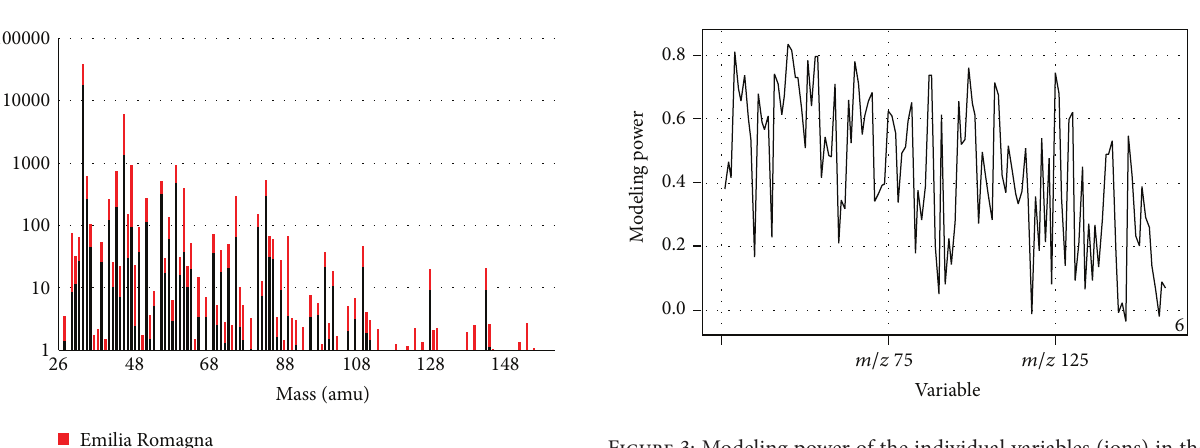
Figure 3: Modeling power of the individual variables (ions) in the Principal Component Analysis of the normalized and autoscaled VOC data of the 2012 and 2013 tomato samples from the Basilicata region and the Emilia Romagna region.